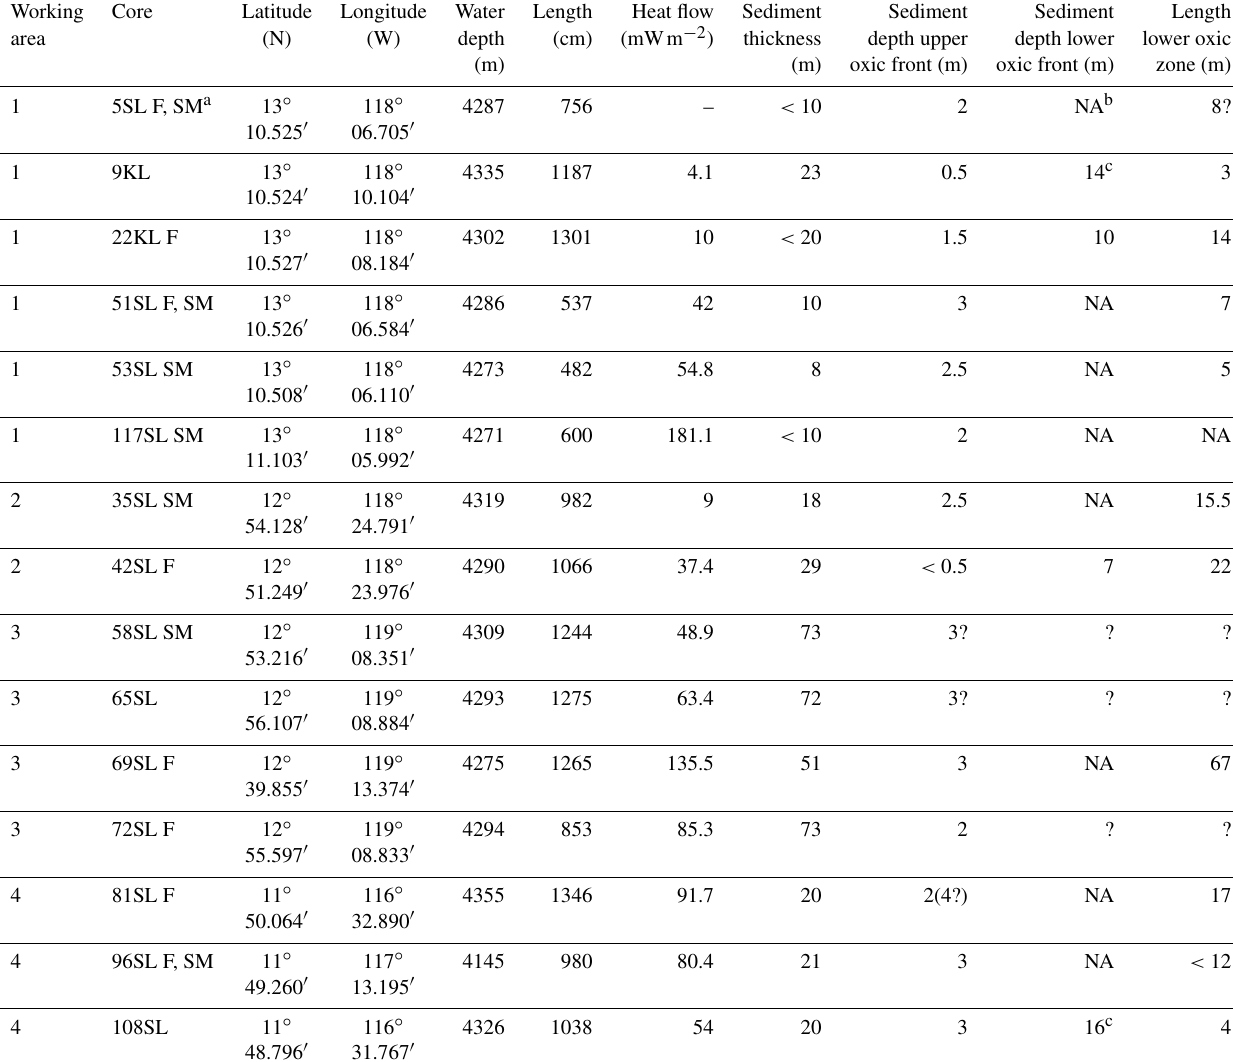
Table 1. Sediment cores analysed (adapted from Kuhn et al., 2015). Working